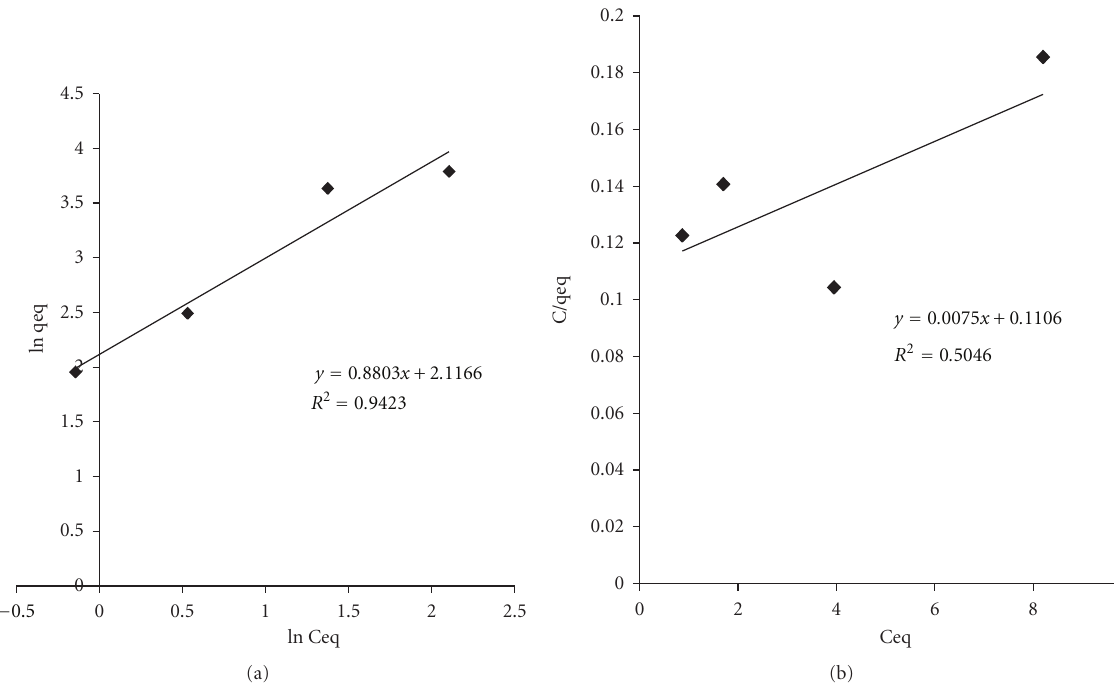
Figure 5: Biosorption isotherm: (a) Freundlich and (b) Langmuir isotherm for Cr(VI) biosorption by T. gamsii biomass at various dilutions of electroplating industrial waste